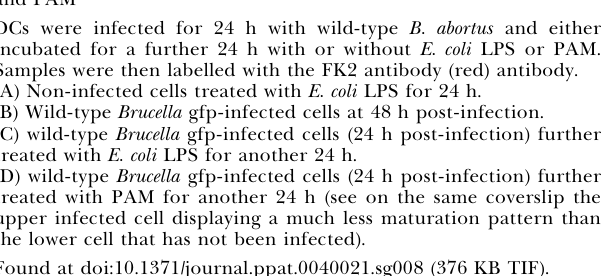
Figure S8. Analysis of the Formation of DALIS in the Presence of LPS and PAM DCs were infected for 24 h with wild-type B. abortus and either incubated for a further 24 h with or without E. coli LPS or PAM. Samples were then labelled with the FK2 antibody (red) antibody. (A) Non-infected cells treated with E. coli LPS for 24 h. (B) Wild-type Brucella gfp-infected cells at 48 h post-infection. (C) wild-type Brucella gfp-infected cells (24 h post-infection) further treated with E. coli LPS for another 24 h. (D) wild-type Brucella gfp-infected cells (24 h post-infection) further treated with PAM for another 24 h (see on the same coverslip the upper infected cell displaying a much less maturation pattern than the lower cell that has not been